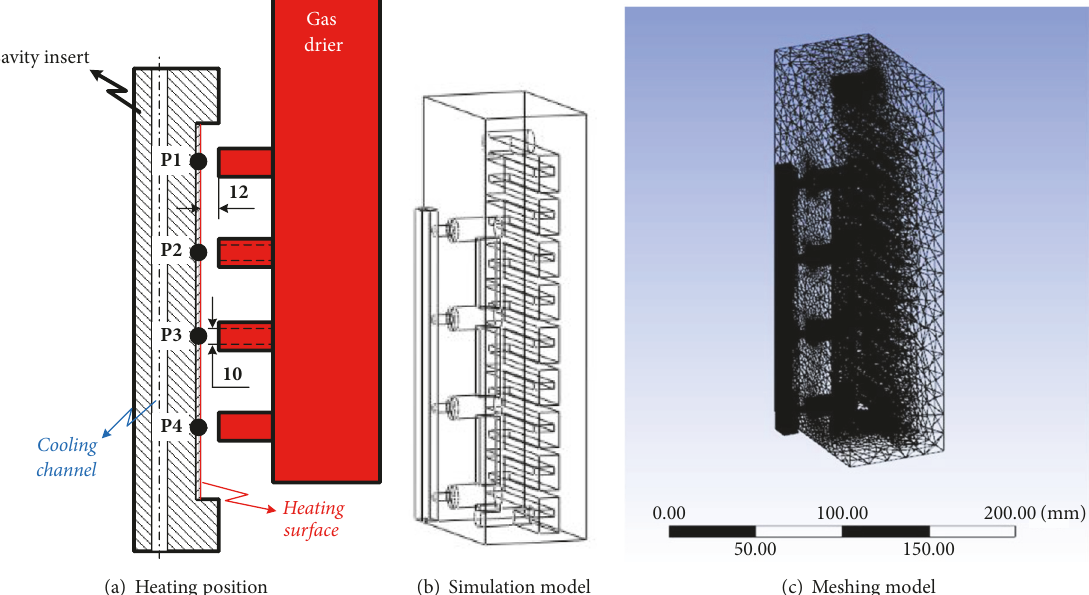
Figure 7: Model of Ex-GMTC with 4 gas gates.